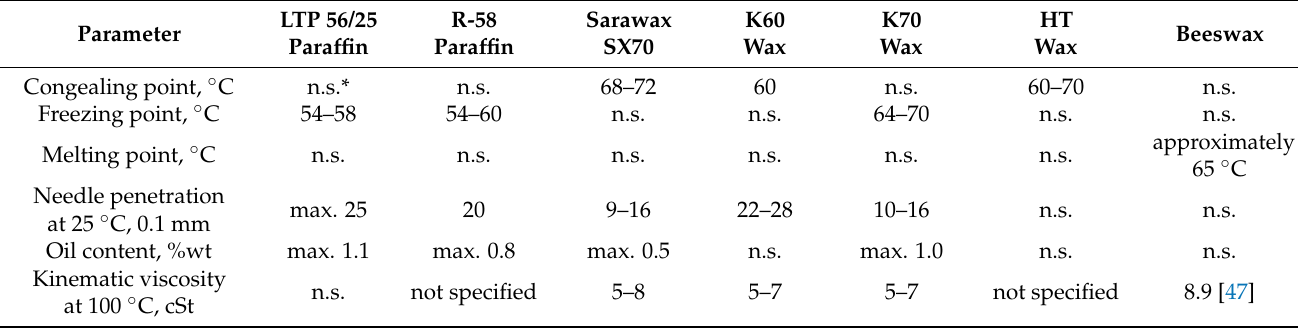
Table 1. Selected properties of paraffins and waxes used for this